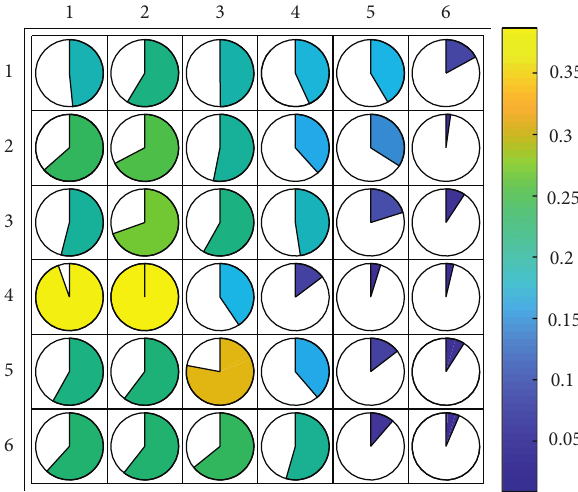
Figure 8: Distribution of the initial values on layer 1 of B 0 .